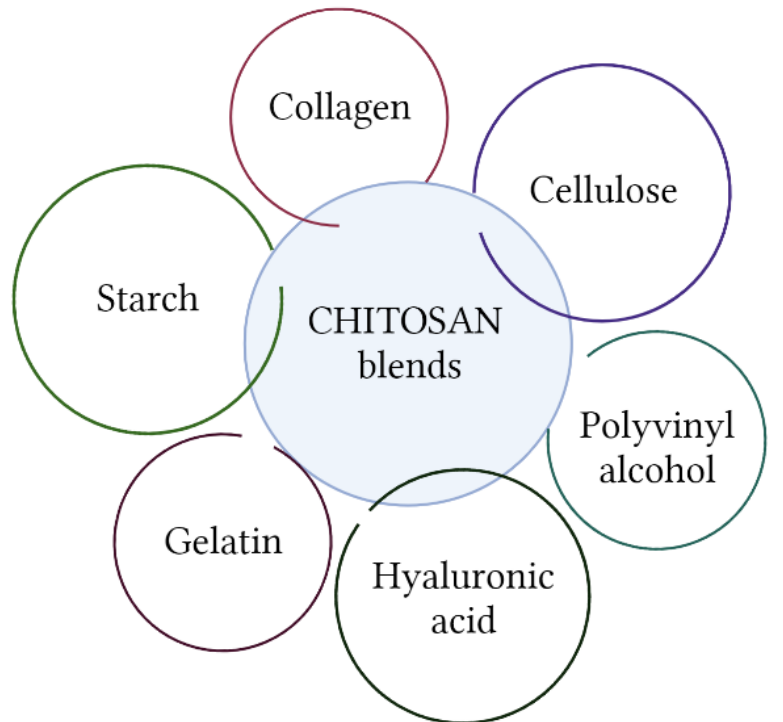
Figure 9. Blends of chitosan with other polymers (Created with BioRender.com; accessed on 18 January 2023).